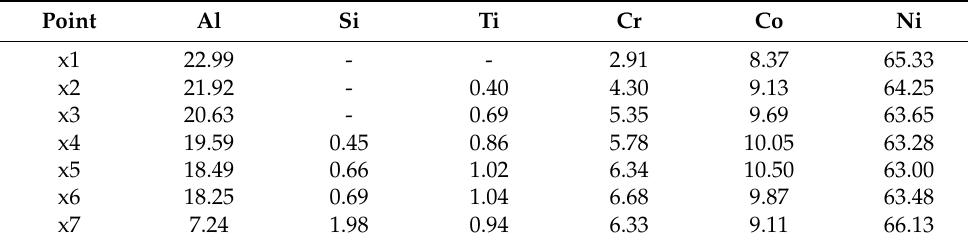
Figure 2. Microstructure of intermetallic coating produced by CVD method on MAR 247 nickel based superalloy at 1040 °C: ( a ) general view of the coating; ( b ) view of coating with points of EDS analysis marked. Table 2. Chemical composition (wt.%) of coating surface obtained after deposition at 1040 °C.